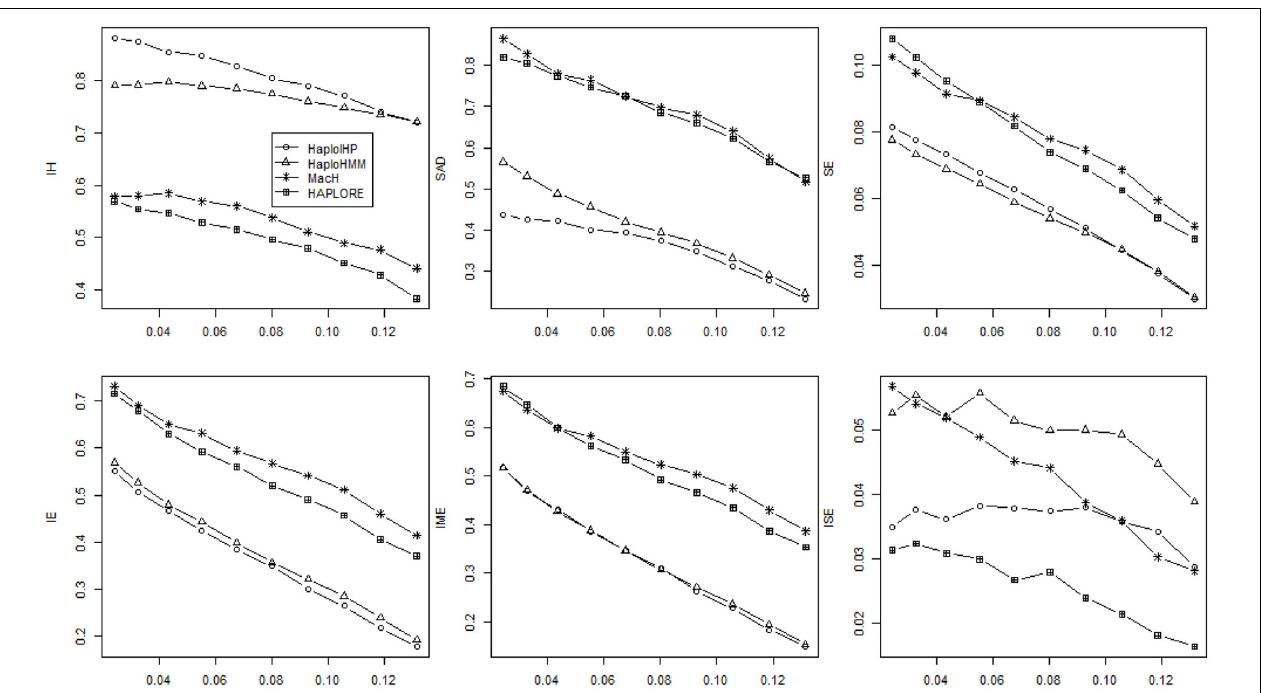
FIGURE 1 | Average values of six measures ( IH , SAD , SE , IE , IME , and ISE ) over 500 replicates with the sample size of 100 and the assumption of HWE under different haplotype frequency distributions. The x-axis